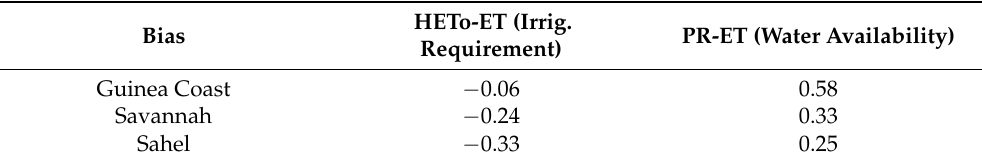
Figure 1. Annual mean climatology of crop water demand ( top row), irrigation requirement ( middle row) (mm/day) from observations/reanalysis data ( left ), and ensemble mean regional climate model output computed using HETo ( middle ) and BRETo ( right ) methods. Bottom panel is for water availability computed based on observational and reanalysis data ( left ) and from ensemble mean regional climate model outputs ( right ). Table 1. Bias (model–observation) in irrigation requirement and water availability (mm/day/year) averaged over the three climatic zones—Guinea Coast, Savannah, and